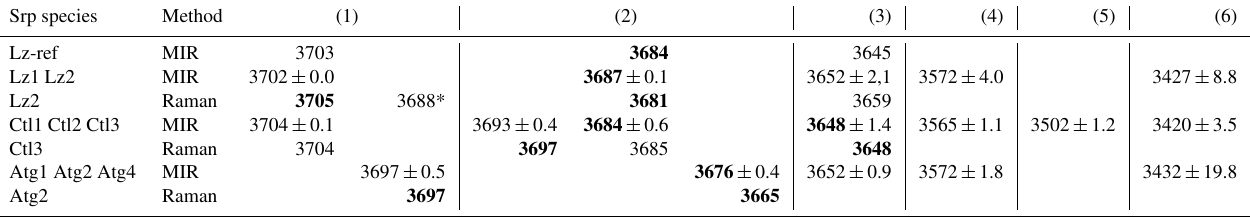
Table 2. Fundamental ( 1v ) average frequency ( w e cm − 1 ) of OH stretching and H 2 O vibration modes measured on decomposed MIR and Raman spectra in lizardite (Lz), chrysotile (Ctl), and antigorite (Atg) from serpentine (Srp) veins of the New Caledonian ophiolite. Reference of lizardite from Balan et al. (2002) is also given for comparison